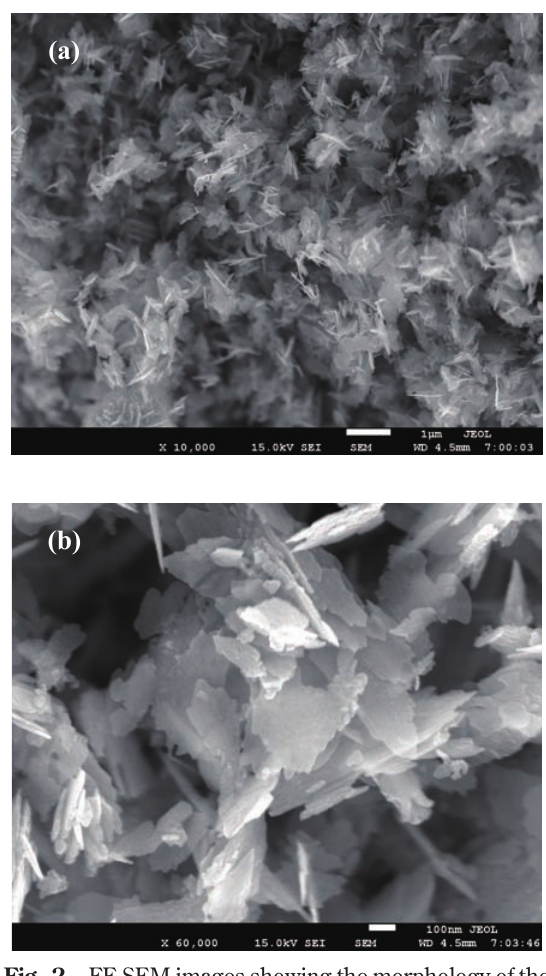
Fig. 2 FE-SEM images showing the morphology of the nanosized ZnO powdered sample. (a) low reso- lution and (b) high